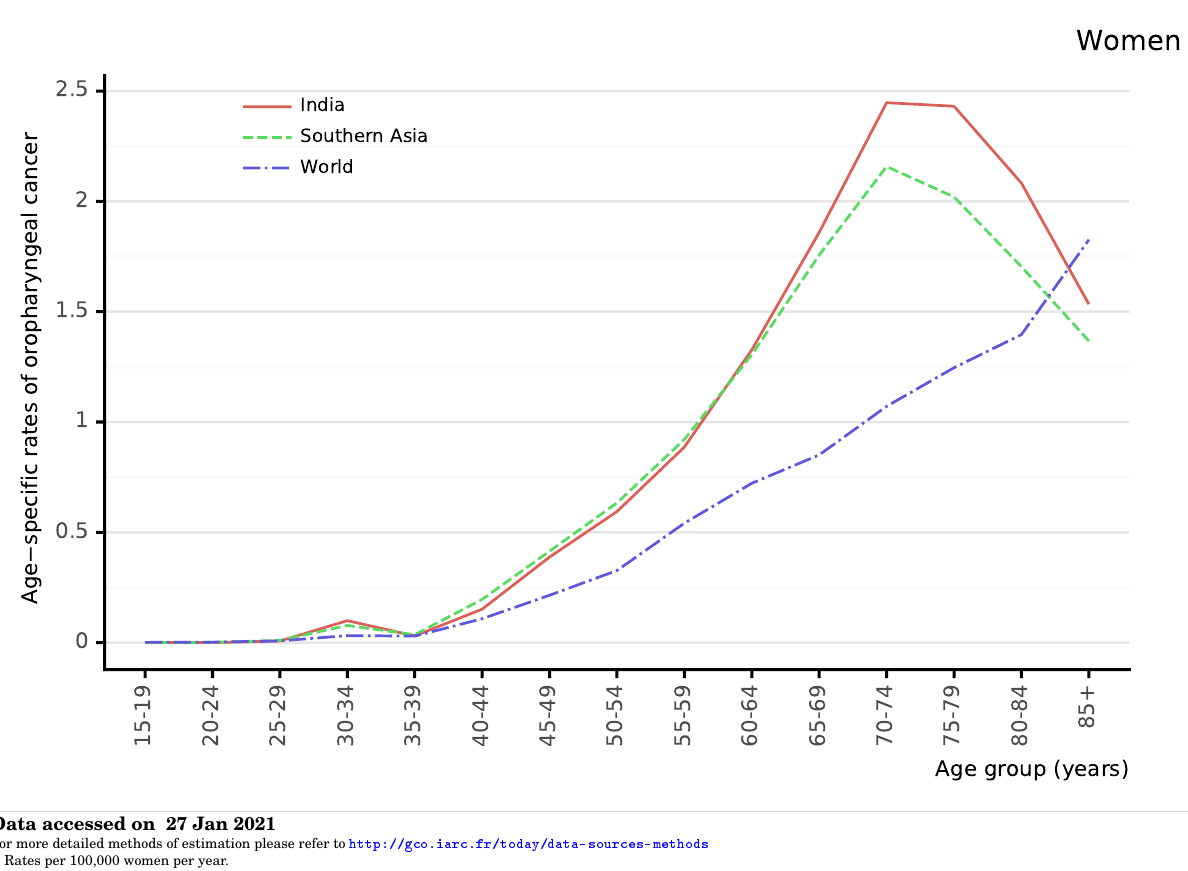
Figure 126: Comparison of age-specific oropharyngeal cancer mortality rates among women by age in India, within the region, and the rest of